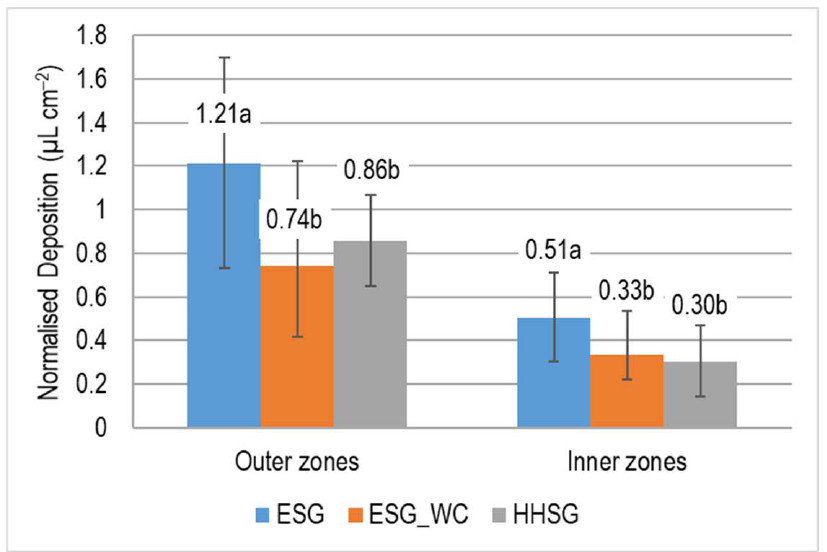
Figure 6. Normalised deposition per unit leaf area in the outer and inner zones of the canopy (µL cm −2 ). The same letter in the same group of bars signifies that there were no significant differences. (Duncan’s test, p < 0.05). Bars signify the means ± SD of the data. ESG: Electrostatic Spray Gun; ESG_WC: Electrostatic Spray Gun Without Charge; HHSG: Hand-Held Spray Gun.